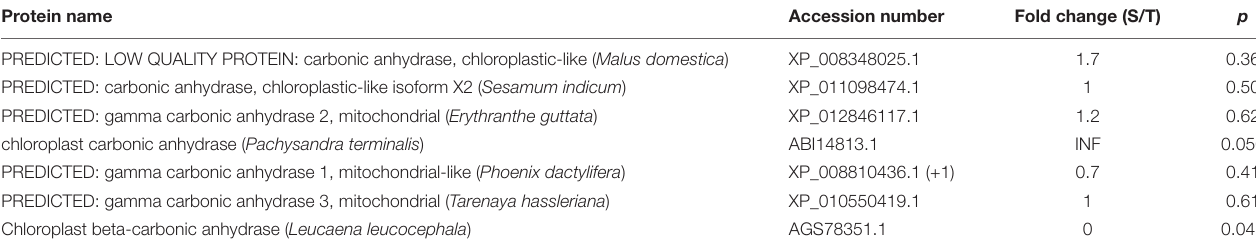
TABLE 2 | Predicted CAs in H. polysperma from proteome analysis.